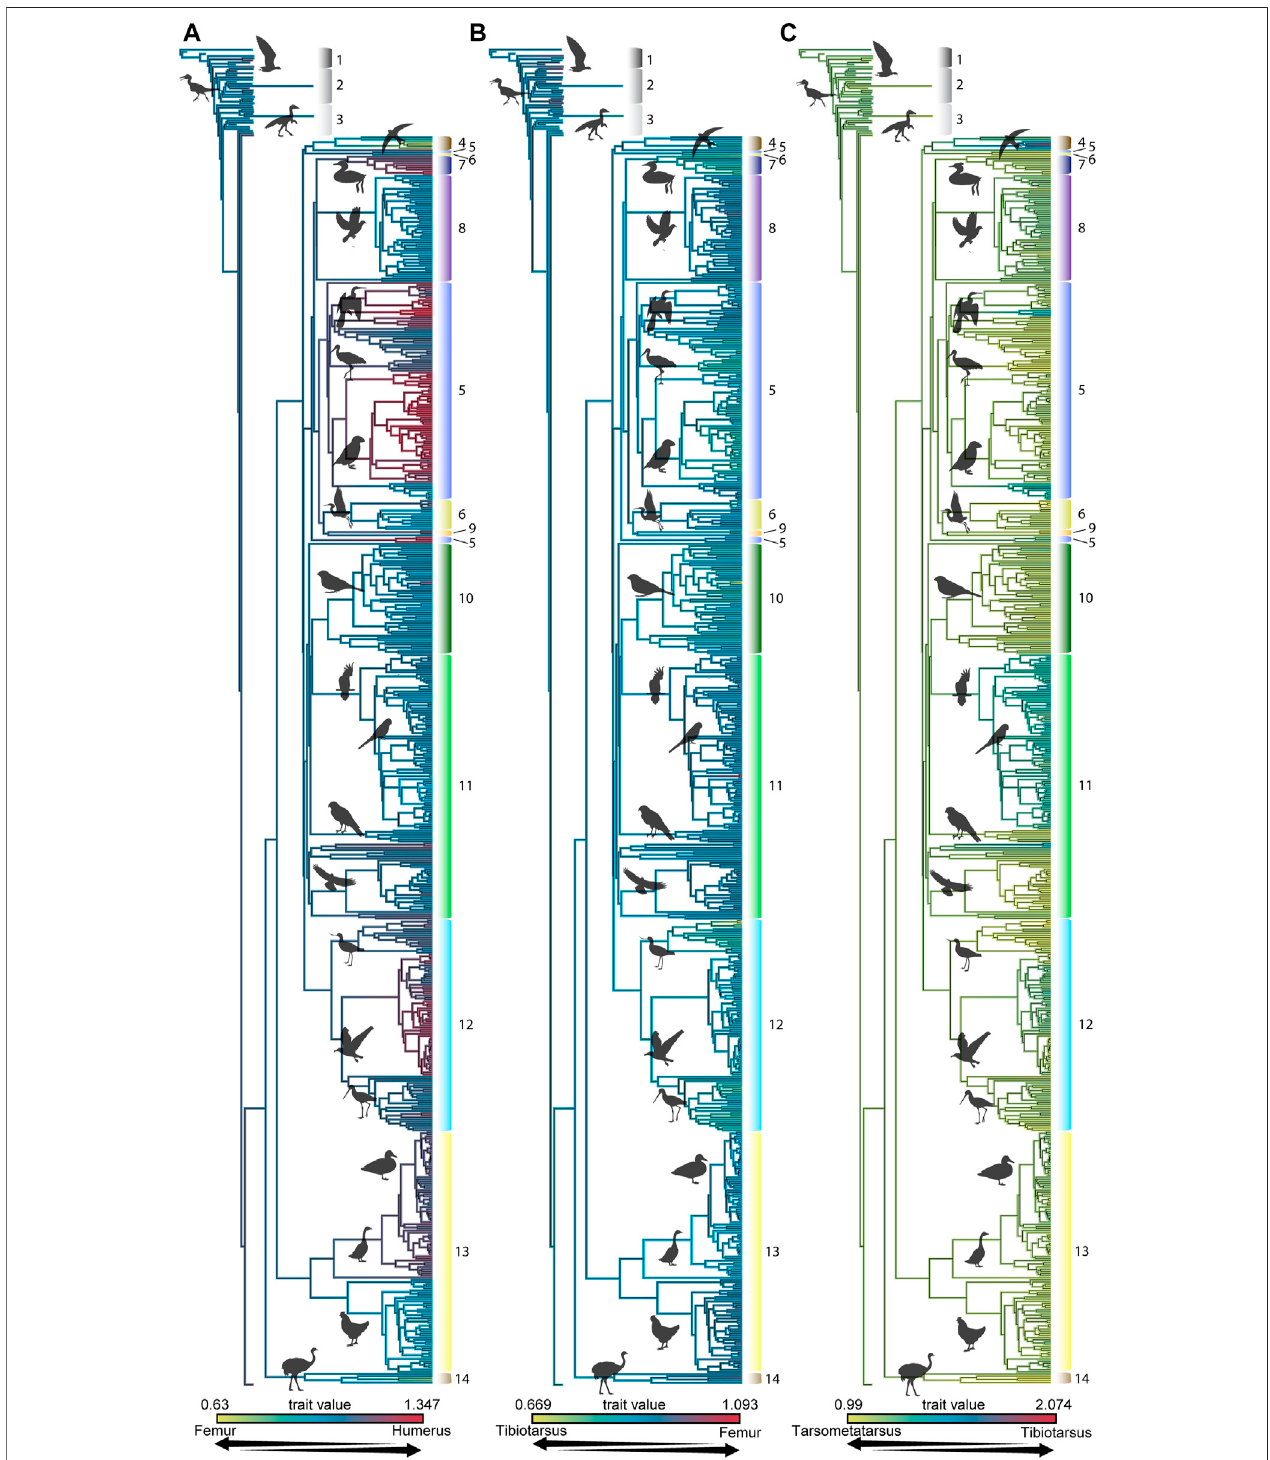
FIGURE4| Proportionsofthelog 10 -transformedlengthsofthehumerustofemur (A) ,femurtotibiotarsus (B) ,andtibiotarsustotarsometatarsus (C) mappedonto the phylogeny created for this analysis. Phylogenetic grade numbers are as follows: 1 Non-ornithothoracine taxa, 2 Enantiornithes, 3 Ornithuromorpha, 4 Strisores, 5 Ardeae, 6 Gruiformes, 7 Mirandornithes, 8 Columbimorphae, 9 Otidimorphae, 10 Passeriformes, 11 Telluraves, 12 Charadriiformes, 13 Galloanserae, 14 Palaeognathae.